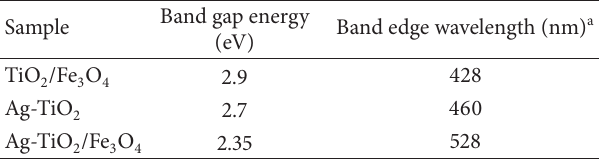
samples. Table 1: Estimated band gap energy of as-synthesized samples.